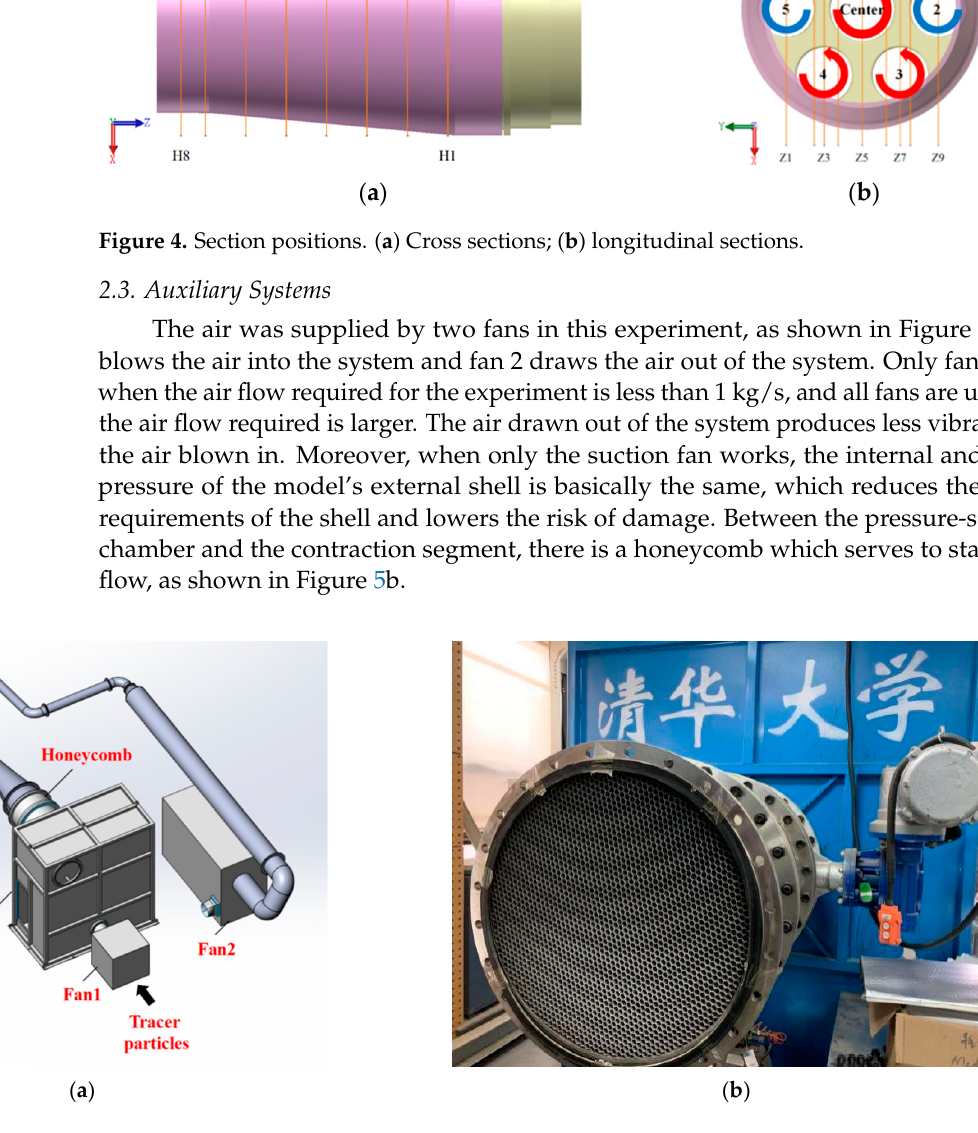
Figure 3. Optical scheme. ( a ) Location of camera and laser; ( b ) Cross section; ( c ) Longitudinal sec- tion.